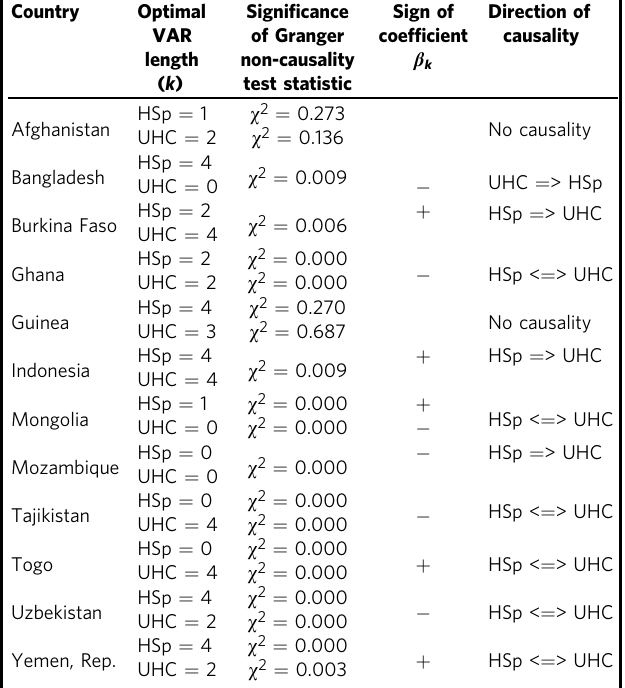
Table 4 Results from the Granger non-causality test (heterogeneous non-causality